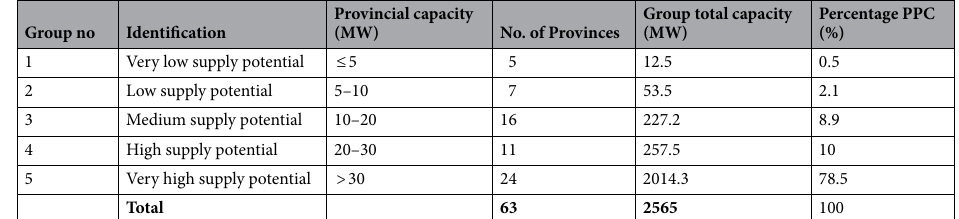
Table 3. Potential of 63 provinces in Vietnam based on RISS availability.